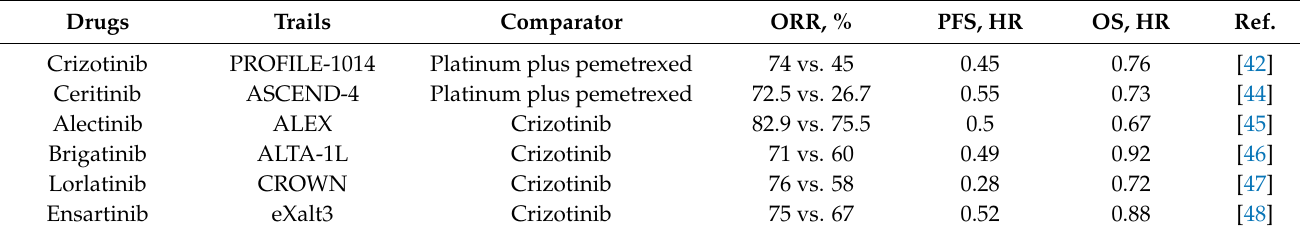
Table 2. Part of the key randomized trials in ALK -positive